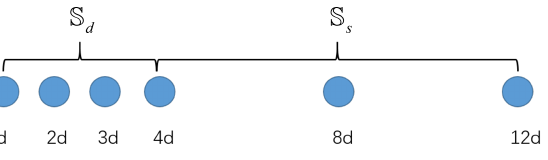
Figure 1. Nested array configuration with R = 6, M = 2, N = 4.